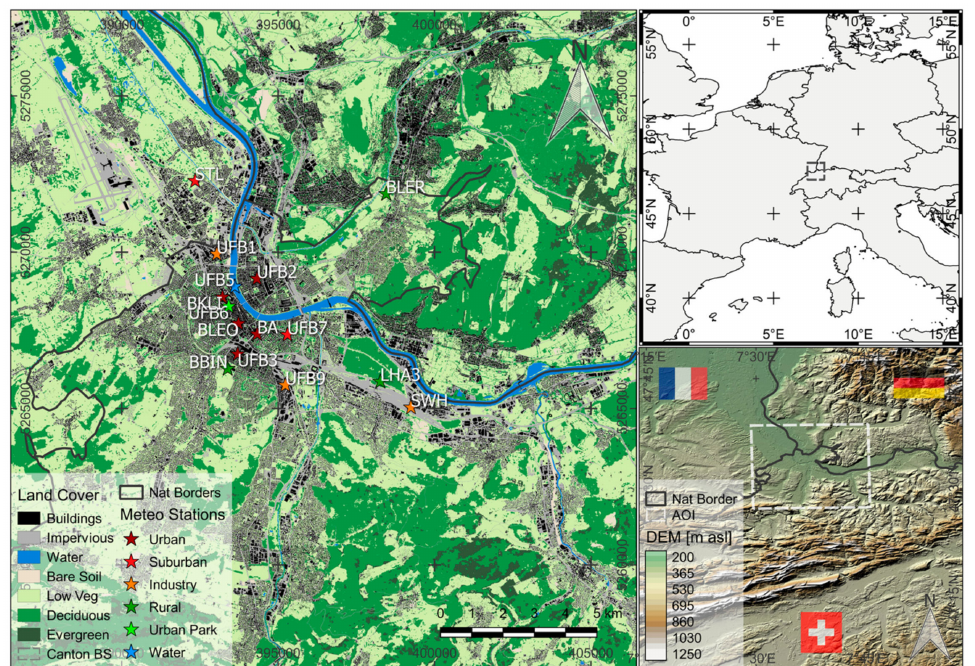
Figure 1. Land cover of the investigation area including classified measurement stations (left, grid reference UTM-32N) and the area of interest (AOI) as a grey rectangle on the topographic map (ASTER GDEM) of the tri-national region France, Germany and Switzerland (lower right), indicated as a grey rectangle in the upper right overview map. Station name and detailed classification can be found in Table